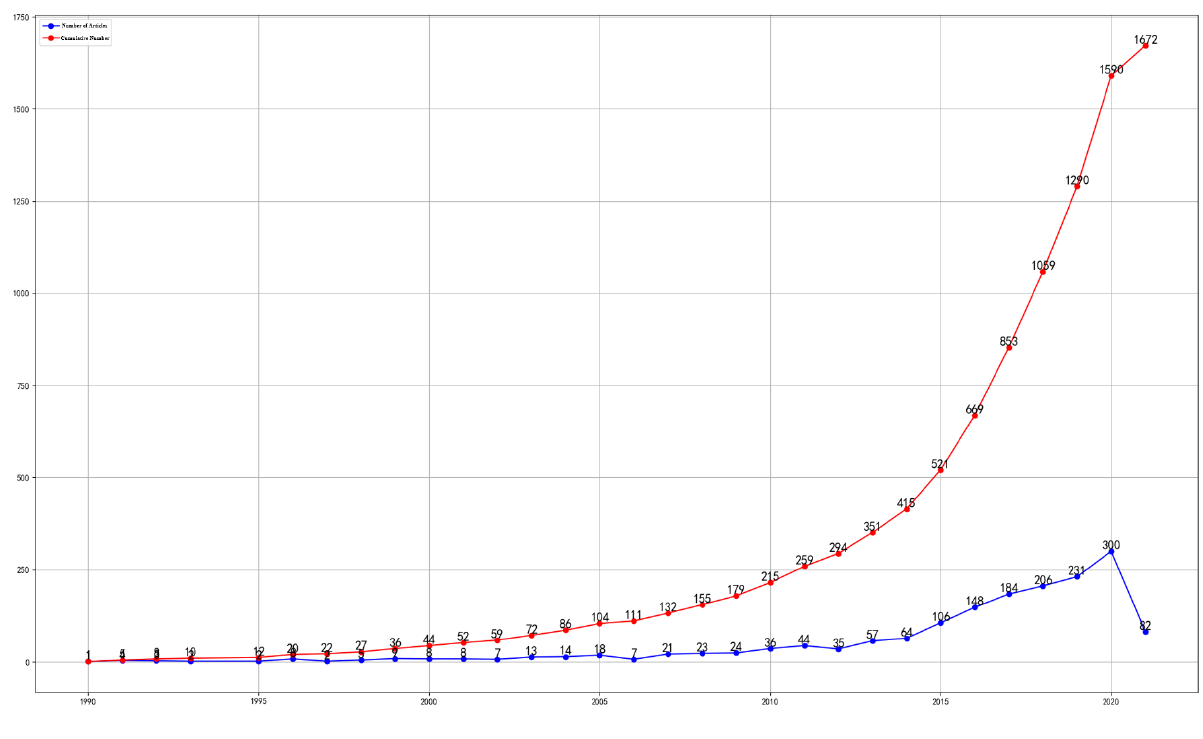
Figure 1. Research progress of data in the food field. From 1990 to 2010, the research papers of big data on food grew at a rate of 100% every five years, and since 2010 it has grown by nearly 300% every five